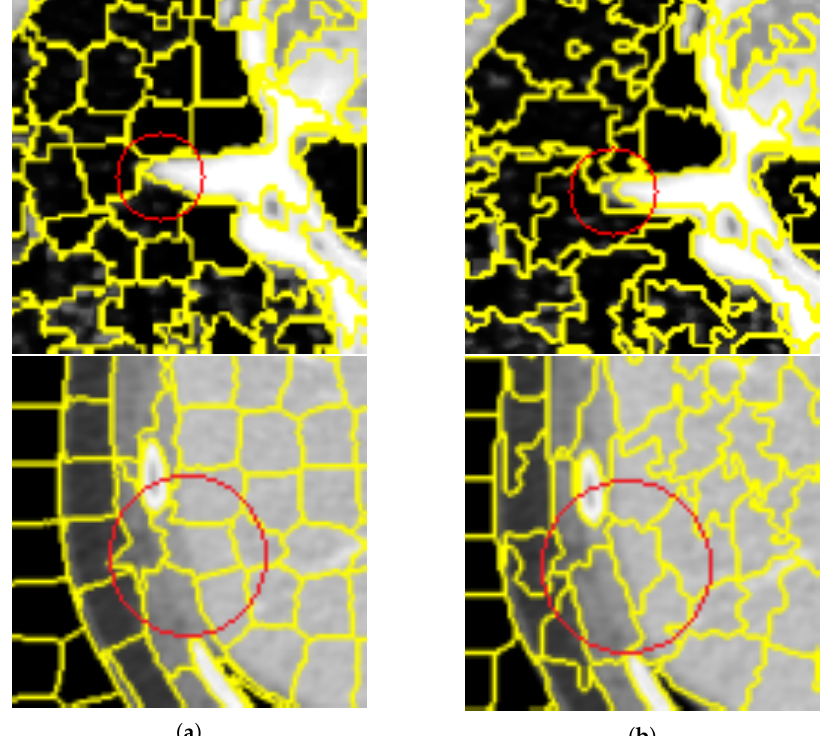
Figure 11. Comparison of segmentation results between SNIC algorithm and the algorithm proposed in this article. ( a , b ) are the super-pixel segmentation results and the corresponding detailed images on the vertebral CT images using the SNIC and our proposed method, respectively. ( a ) The SNIC algorithm. ( b ) Proposed